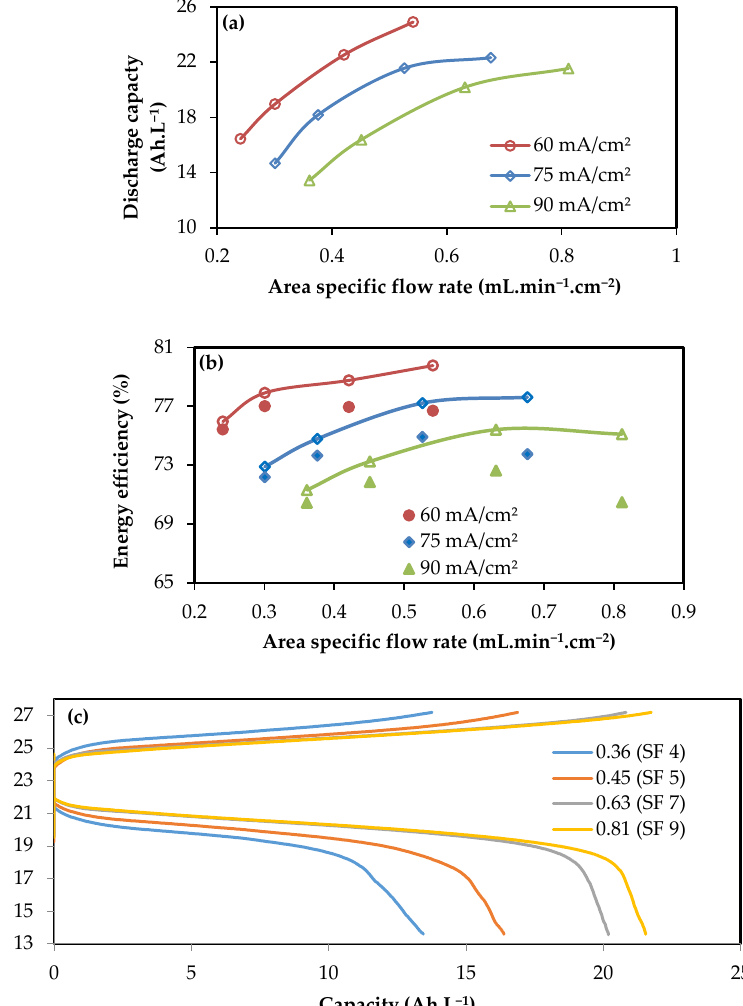
Figure 5. Electrochemical performance data for the 16 cell—410 cm 2 stack as a function of area specific flow rate and current density: ( a ) discharge capacity and ( b ) energy efficiency, including pumping energy consumption (closed symbols) and excluding pumping energy consumption (open symbols). ( c ) Charge–discharge life-cycle behavior of the stack for various flow rates in mL.min −1 .cm −2 (with corresponding stoichiometric flow (SF) factors) at fixed current density of 90 mA.cm −2 .